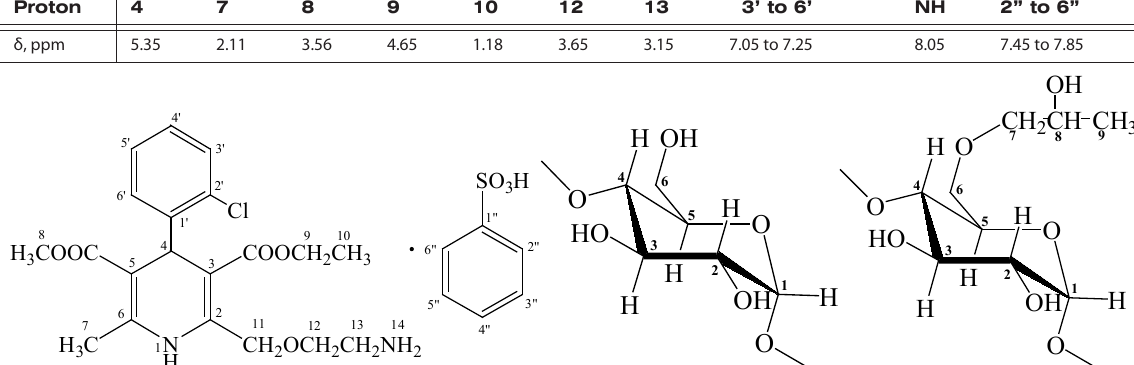
Figure 3. Structure of amlodipine besylate, β-cyclodextrin and 2-hydroxypropyl-β-cyclodextrin with marked C-atoms